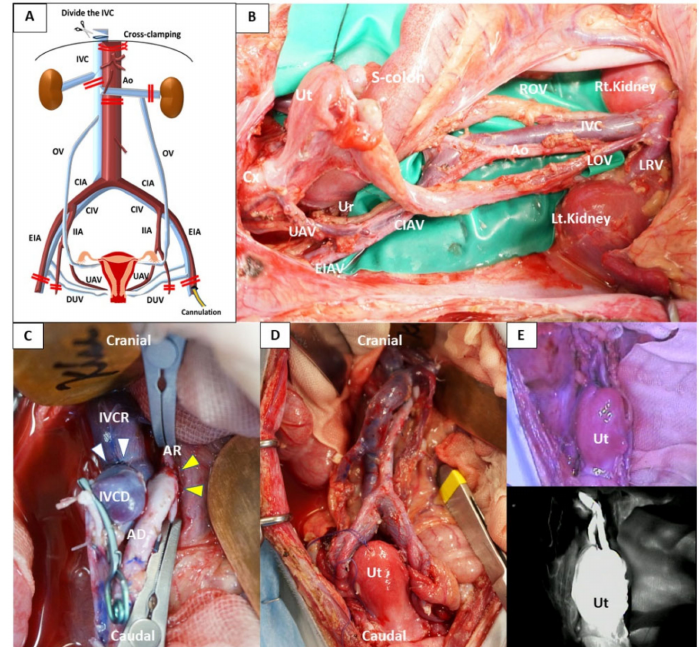
Figure 1. Donor and recipient surgery. ( A ) Schema of abdominal vessels dissected during donor surgery. Cross-clamping was performed by clamping the supraceliac aorta under the diaphragm and dividing the inferior vena cava (IVC) in the pleural space. A perfusion catheter was placed in the unilateral external iliac artery. ( B ) Dissection of the abdominal vessels and tissues surrounding the uterus before procurement of the uterus via donor surgery. Infrarenal aorta / IVC above the left renal vein, iliac and uterine vessels, and ovarian veins were dissected. Subsequently en bloc procurement of the uterus with these vessels and proximal vagina was performed. ( C ) Vascular anastomosis in recipient surgery. End-to-side venous anastomosis between the IVC of the donor and that of the recipient (white triangle) and between the abdominal aorta of the donor and the abdominal aorta of the recipient (yellow triangle). ( D ) Transplanted uterus. Following reperfusion, the color of the transplanted uterus changed from white to red without uterine congestion. ( E ) Intraoperative indocyanine green (ICG) fluorescent angiography in the transplanted uterus. ICG fluorescent angiography showed that there was su ffi cient blood flow to the transplanted uterus immediately following reperfusion (before (upper panel) and after (lower panel) injection of